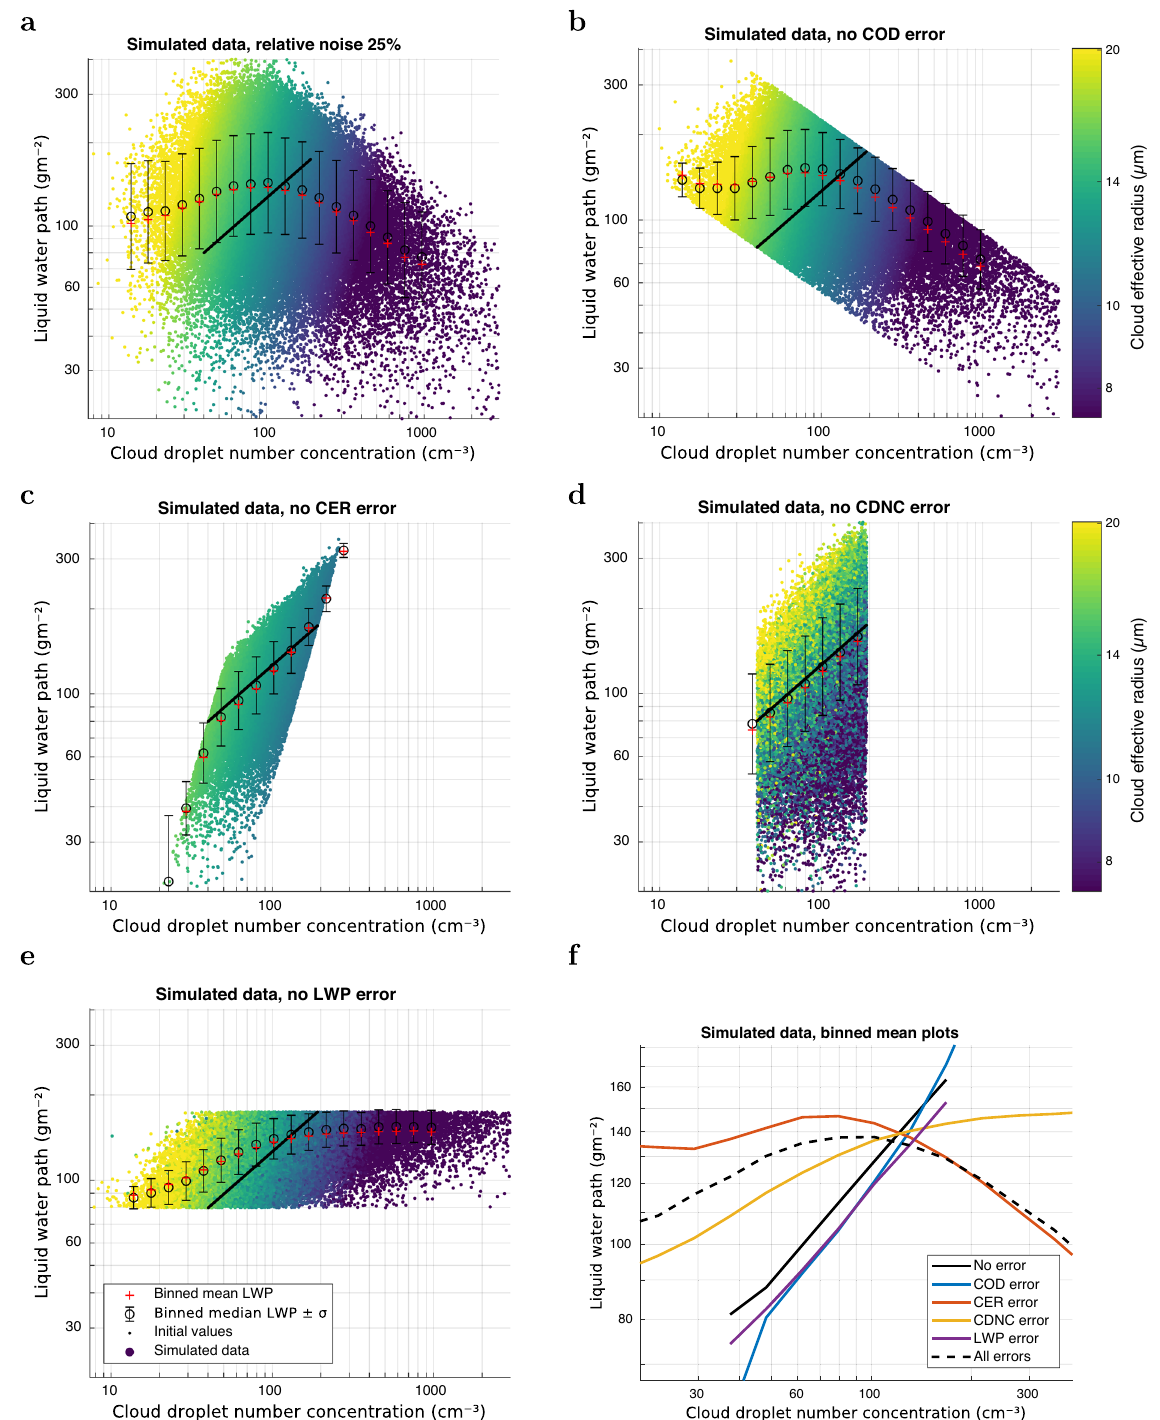
Fig.3|Clouddropletnumberconcentration(CDNC)vsliquidwaterpath(LWP) patterns in different cases ofcloud opticaldepth(COD) and/or cloud effective radius (CER) variability/error. Relative error of 25% was used, and LWP adjust- mentwassetto0.5. a VariabilitywasappliedtobothCERandCODandpropagated to CDNC and LWP. b Variability was not applied to COD, only to CER. c Variability was not applied to CER, only to COD. d Variability was applied to both COD and CER, but was not propagated to CDNC, only to LWP. e Variability was not